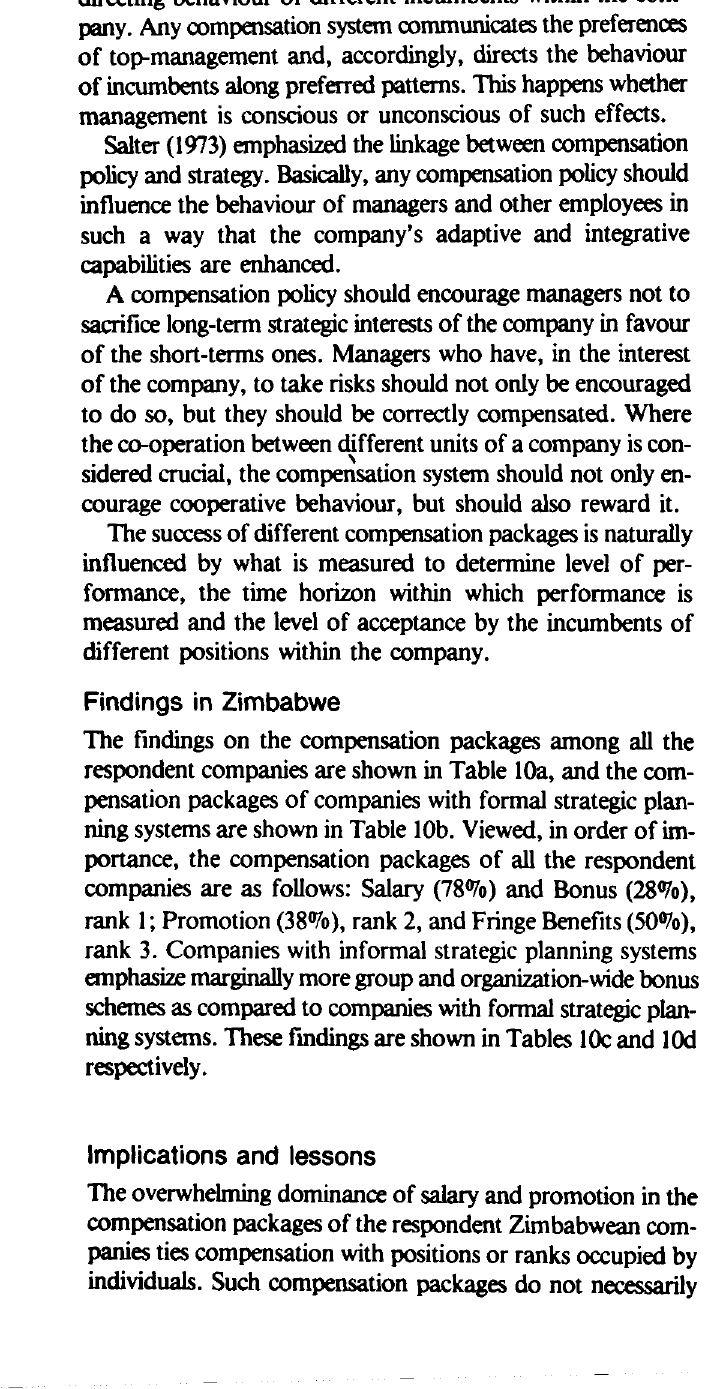
Table 10b Compensation system (Respondent com